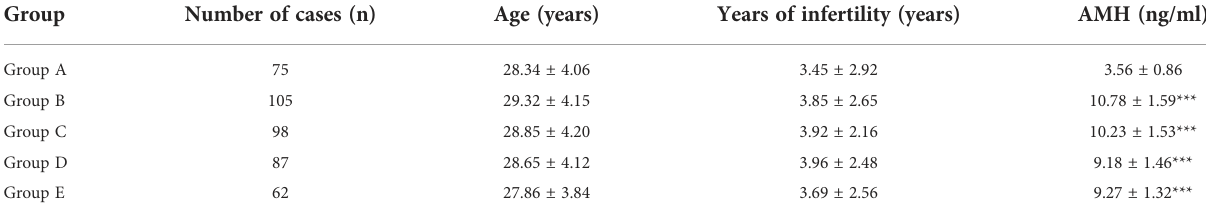
TABLE 2 Patients ’ characteristic.